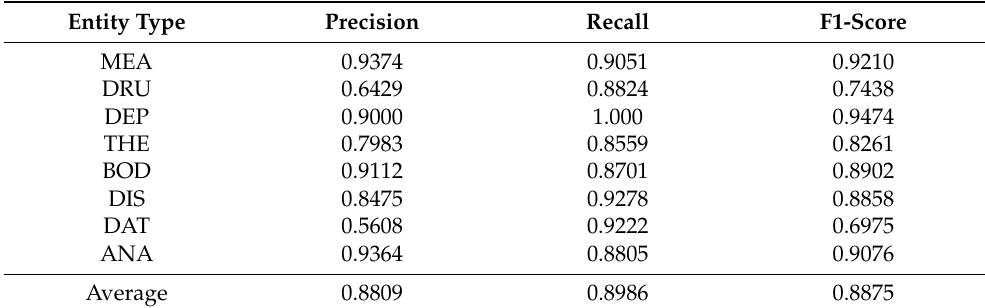
Table 9. Results in terms of precision, recall and F1-Score averaged on all classes obtained with the DNN with ELMo embeddings trained on the final annotated corpus and tested on the out-of-corpus test set.